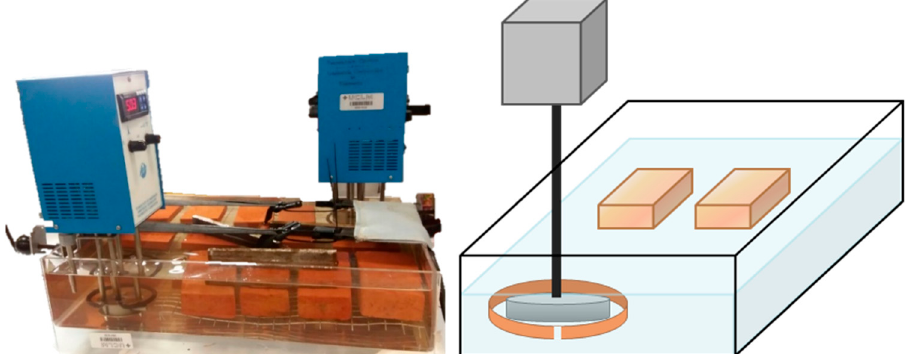
Figure 1. Scheme of the immersion system for the preparation of the form-stable phase-change material (PCMs).